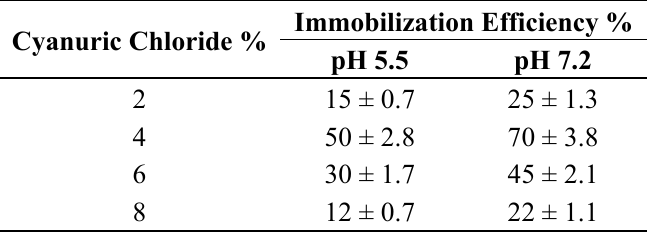
Table 1. Effect of cyanuric chloride percentage and pH on the immobilization efficiency of Trichoderma harzianum α -amylase (200 units).